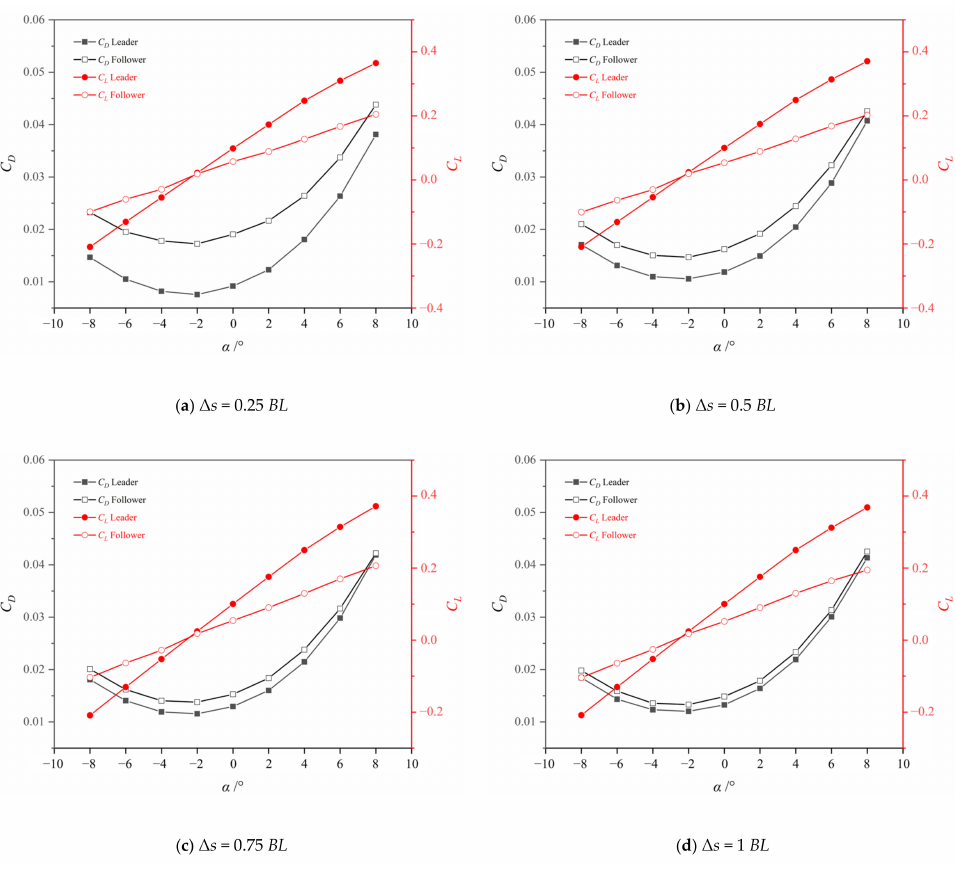
Figure 9. The variation of the resistance coefficient and lift coefficient with the angle of attack of two manta rays at different